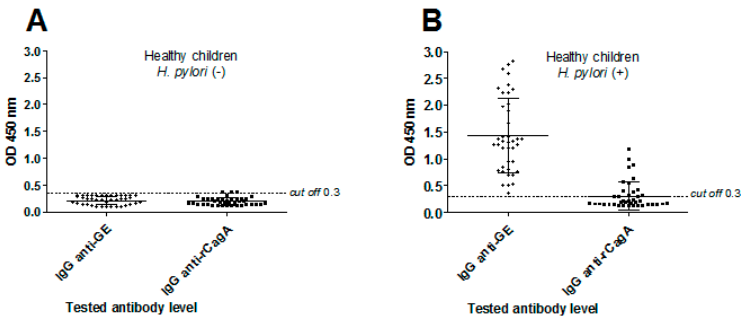
Figure 2. The prevalence and levels of anti- H. pylori antigenic complex glycine extract (GE) and anti-CagA, IgG antibody production in H. pylori -uninfected or H. pylori -infected children. ( A ) Healthy children seronegative for anti- H. pylori antibodies— H. pylori ( − ), n = 43; ( B ) Children infected with H. pylori , seropositive for anti- H. pylori antibodies— H. pylori ( + ), n = 41. Shown are mean values ± standard deviation (SD).